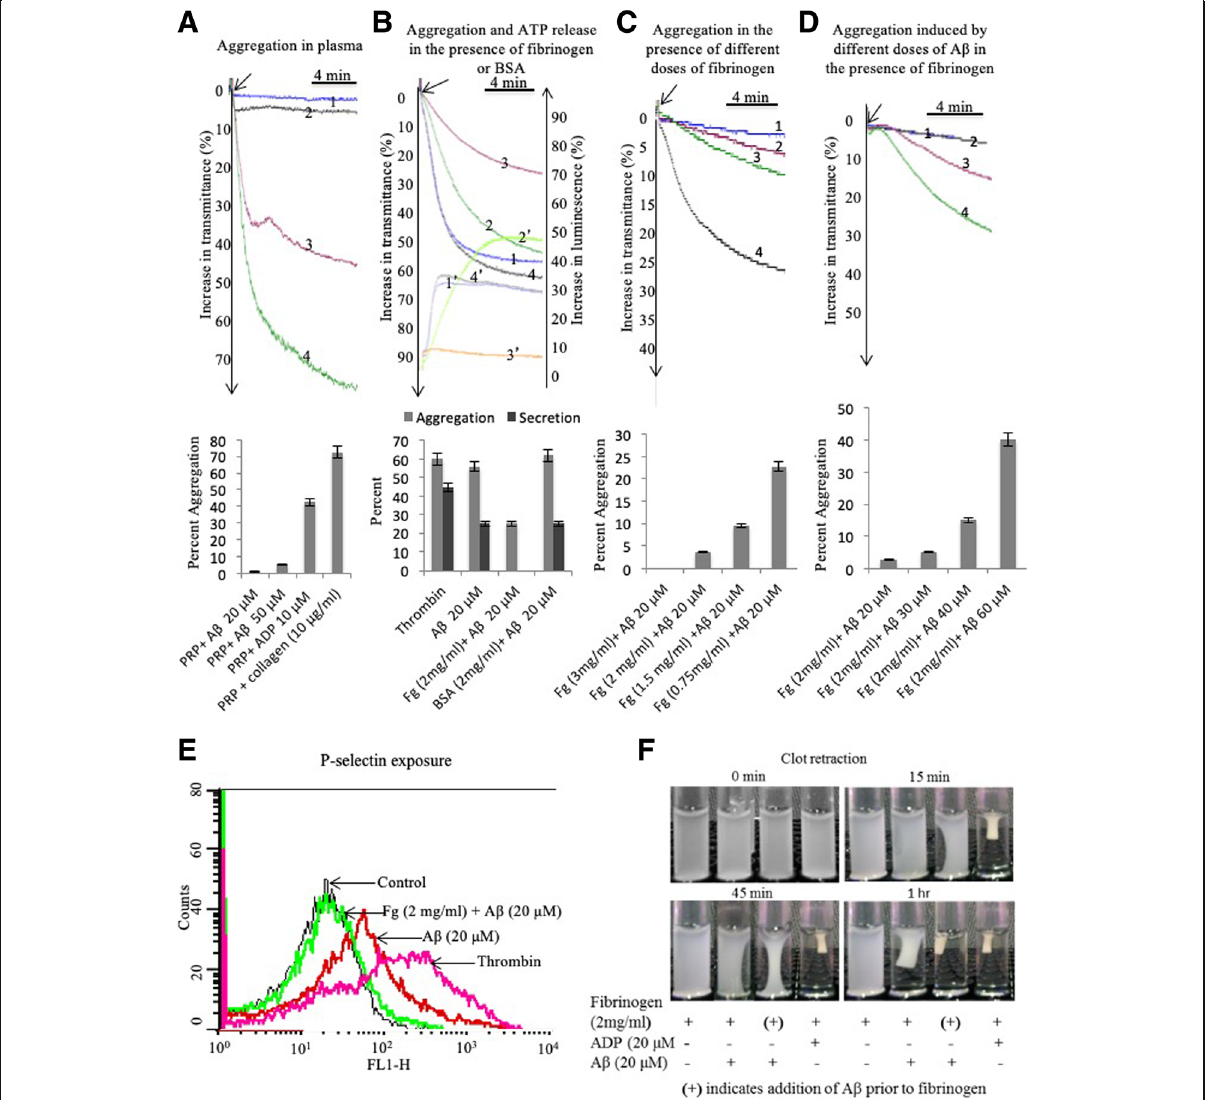
Fig. 1 Effect of fibrinogen on A β 25 – 35 -induced platelet activation. a Tracings 1, 2, 3 and 4 represent platelet aggregation in PRP induced by A β 25 – 35 (20 and 50 μ mol/L), ADP (20 μ mol/L) and collagen (10 μ g/mL), respectively. The corresponding bar diagram is shown in the lower panel. b Tracings 1 – 4 represent aggregation, and tracings 1 ′– 4 ′ represent corresponding dense granule secretion in washed platelets stimulated with either thrombin (1U/ mL; tracings 2 and 2 ′ ) or A β 25 – 35 (20 μ mol/L; tracings 1, 1 ′ , 3, 3 ′ , 4 and 4 ′ ). Tracings 3 and 3 ′ represent platelets pretreated with fibrinogen (2mg/mL), whereas tracings 4 and 4 ′ represent platelets pretreated with BSA (2mg/mL). Corresponding bar diagram is shown in the lower panel. c Tracings 1, 2, 3 and 4 represent aggregation of washed platelets induced by A β 25 – 35 (20 μ mol/L) in the presence of 3, 2, 1.5 and 0.75mg/mL fibrinogen, respectively. Corresponding bar diagram is shown in the lower panel. d Tracings 1, 2, 3 and 4 represent aggregation of washed platelets induced by A β 25 – 35 (20, 30, 40 and 60 μ mol/L, respectively) in the presence of fibrinogen (2 mg/mL). Corresponding bar diagram is shown in the lower panel. e Flow cytometric analysis of expression of P-selectin on surface of platelets treated with different reagents and agonists as indicated. f Retraction of fibrin clot by platelets stimulated with either A β 25 – 35 (20 μ mol/L) or ADP (20 μ mol/L) in presence of fibrinogen (2 mg/mL) added either before or after exposure to agonists as